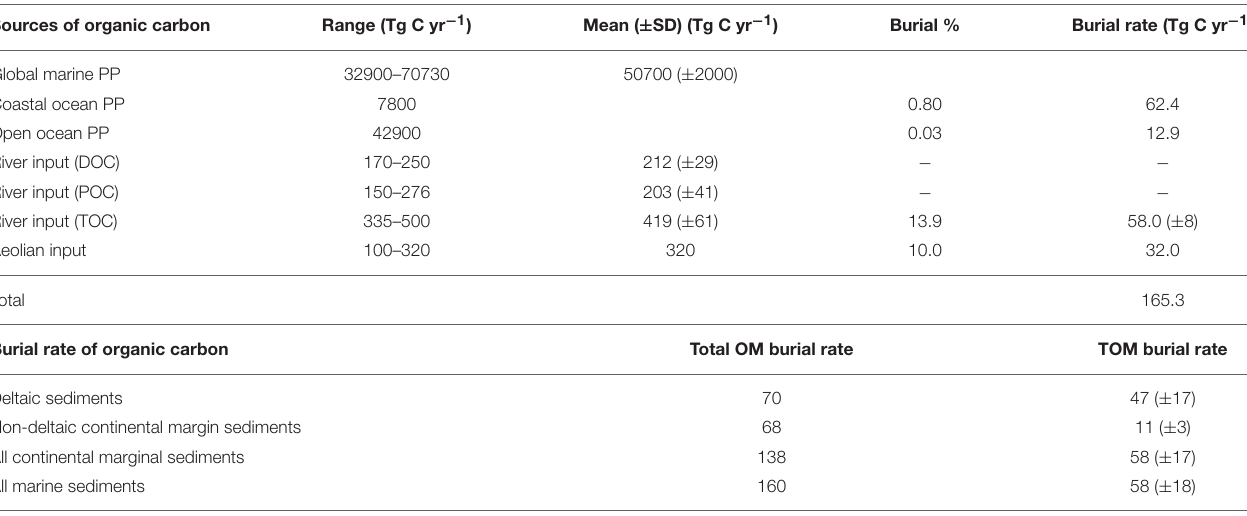
TABLE 3 | Global sources of organic carbon input to the ocean basins and burial rates of organic carbon in the ocean (Tg C yr − 1 ). Sources of organic